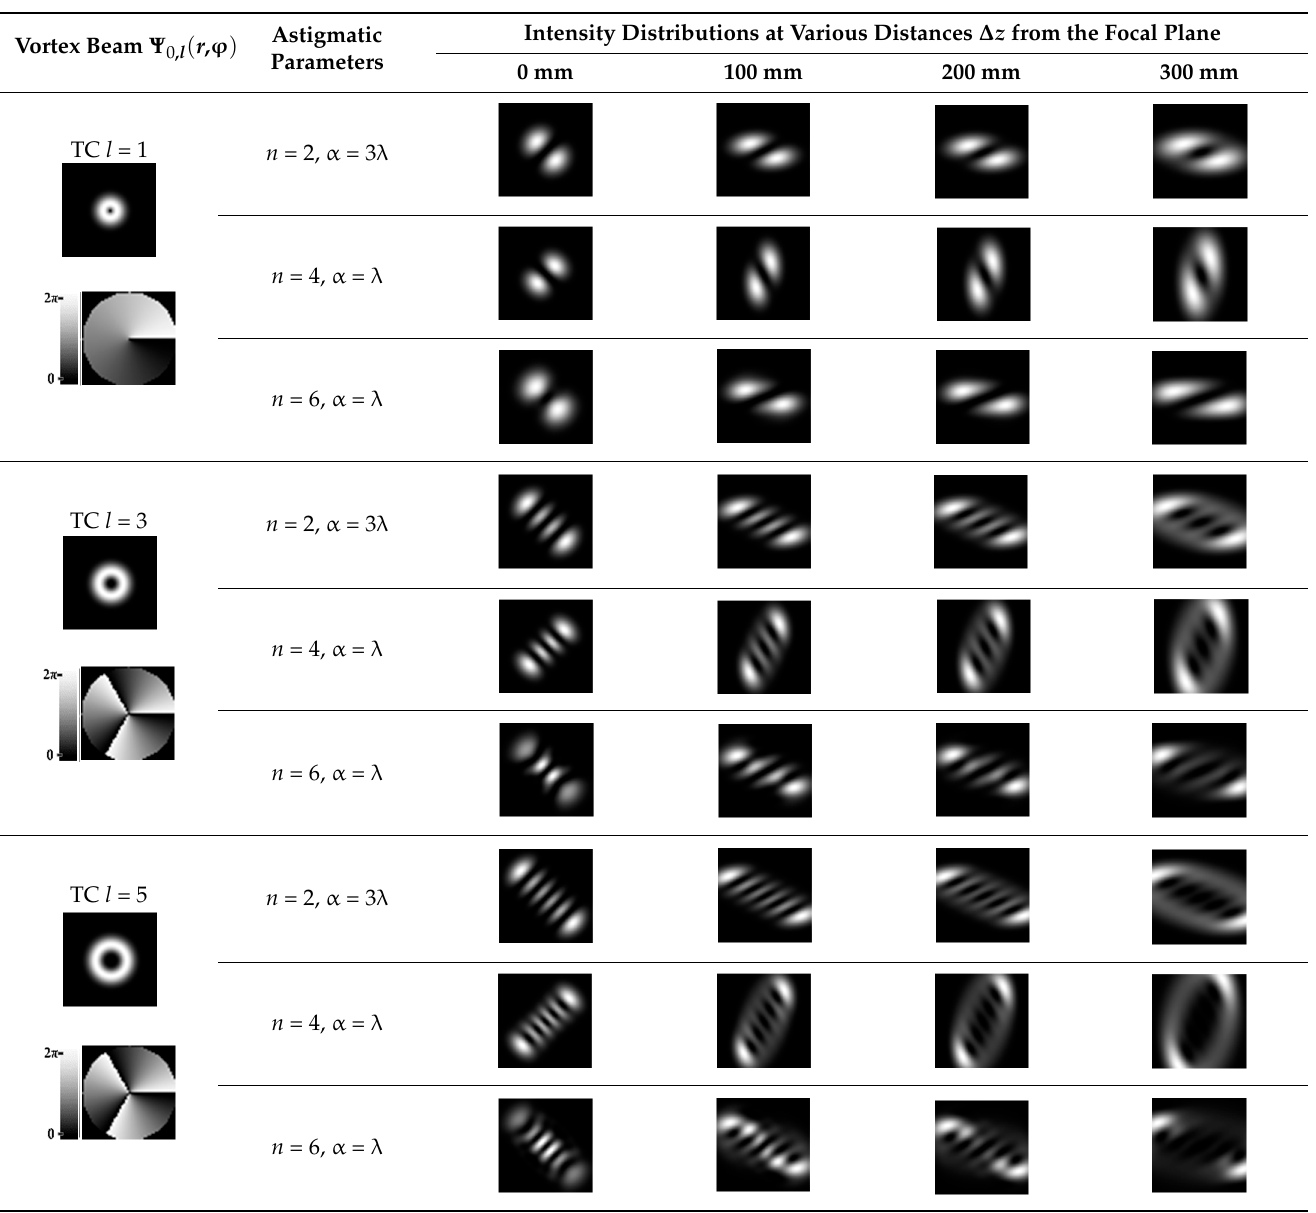
Table 4. Simulation results of astigmatic transformation of vortex beams Ψ 0, l ( r , ϕ ) with aberrations of the form exp [ ik α Z n ,2 ( r , ϕ )] at various distances ∆ z from the focal plane.